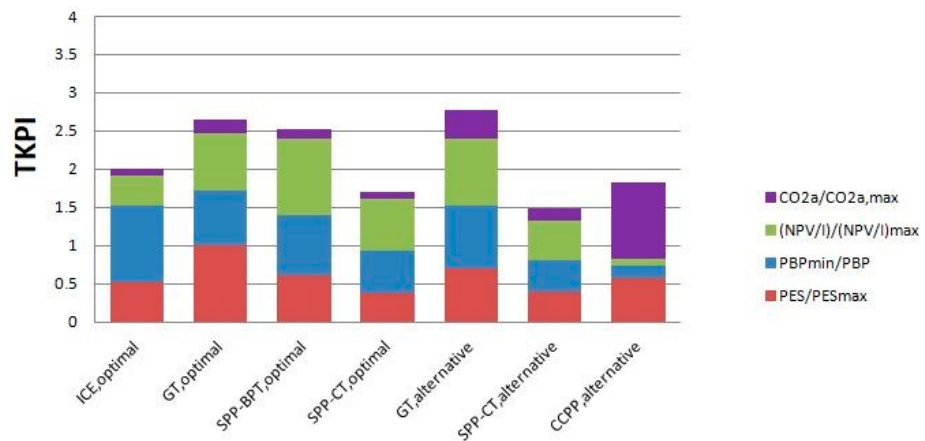
Figure 10. TKPI values and breakdown for the considered cogeneration technologies with white certificates taken into account (combining optimal design and alternative design).